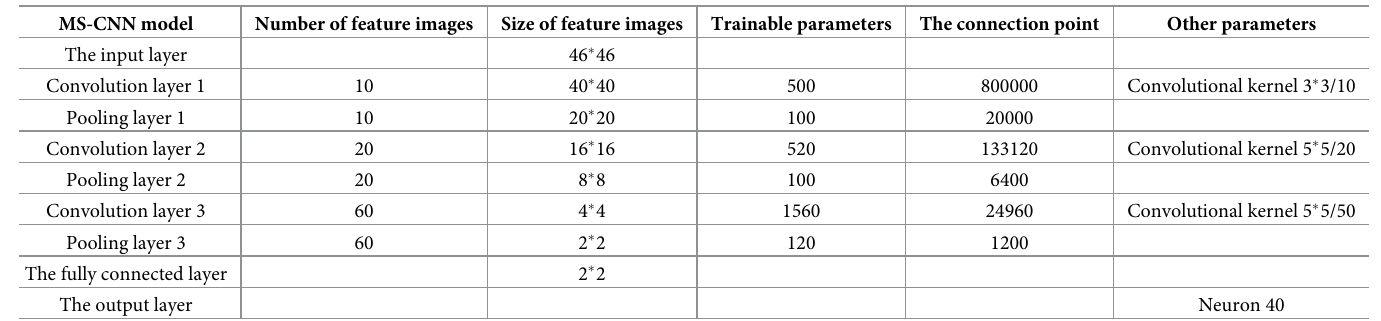
Table 1. Parameters of all layers in MS-CNN model.